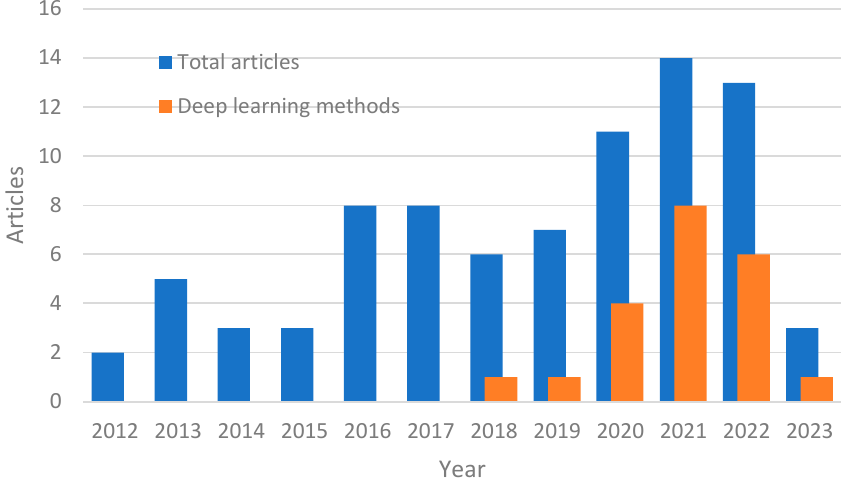
Figure 2. The number of reviewed unsupervised learning-based SHM studies using deep learning and the total reviewed articles over the years since 2012.